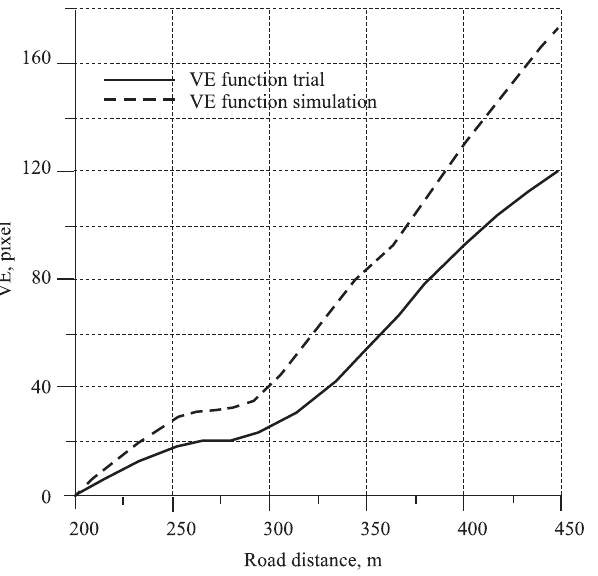
Fig. 9. Comparison of the CVE between the original and simulated scenarios in the section 200 – 450